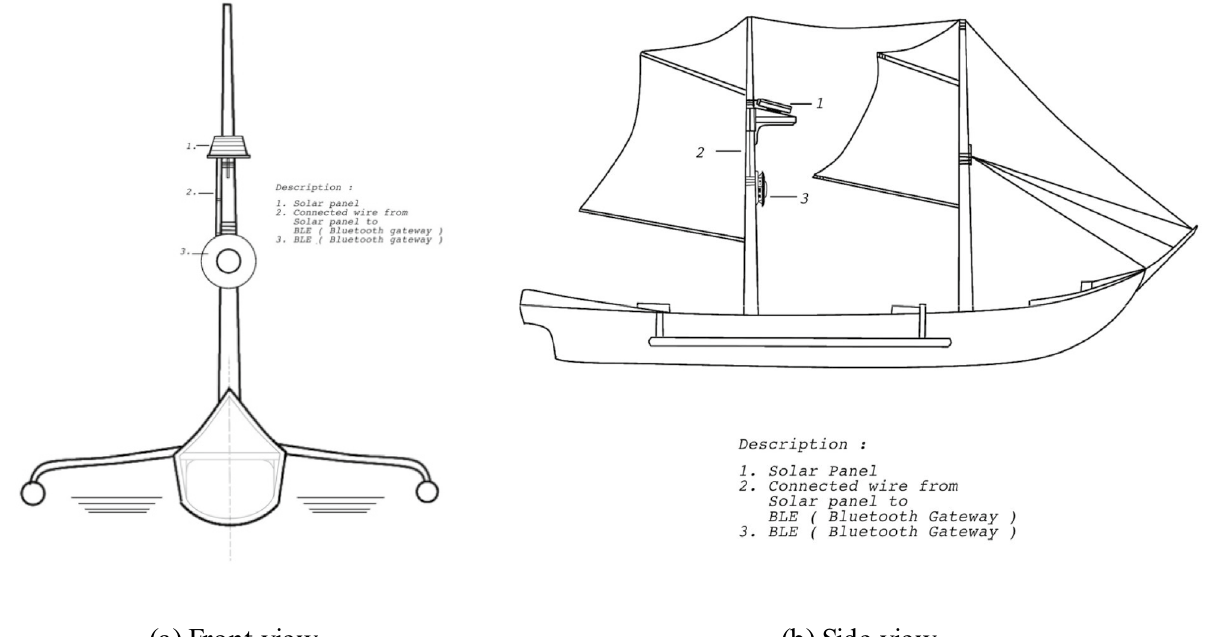
Fig. 4 Placement (location) of solar panel device in the boat from two sides: front view and side